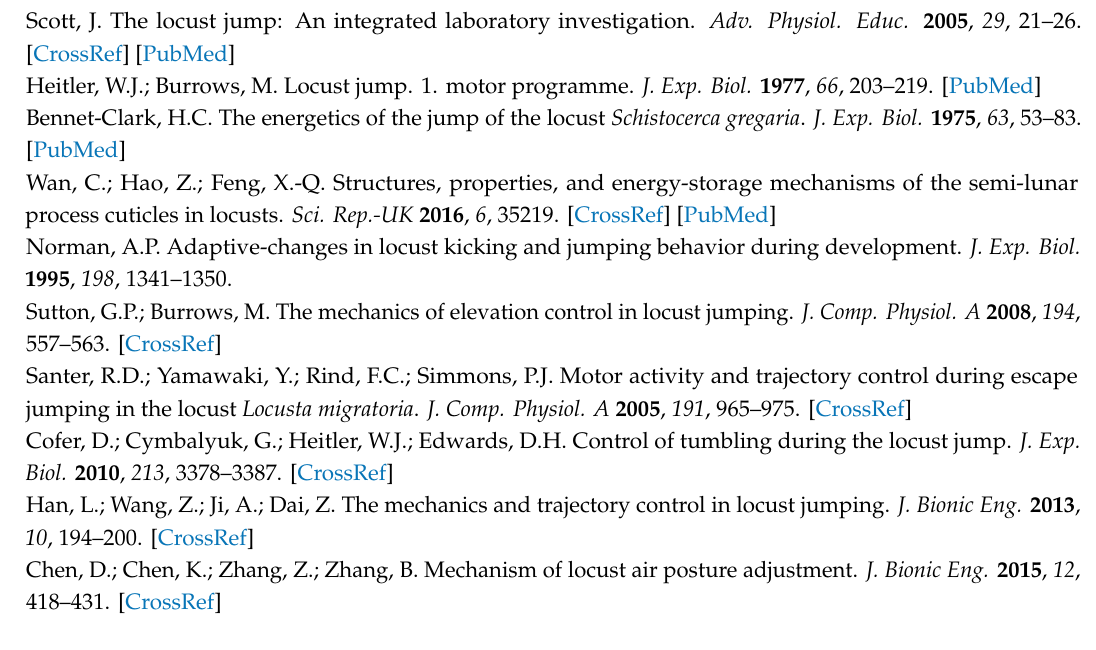
Table S1: Experimental data of the kinematics for the locusts jumping on sand, Table S2: Experimental data of the kinematics for the locusts jumping on soil, Table S3. Experimental data of the kinematics for the locusts jumping on wood, Table S4: Experimental data of the reaction force for the locusts jumping on sand, Table S5: Experimental data of the reaction force for the locusts jumping on soil, Table S6: Experimental data of the reaction force for the locusts jumping on wood, Video S1: A typical video of the locust jumping on sand, Video S2: A typical video of the locust jumping on soil, Video S3: A typical video of the locust jumping on